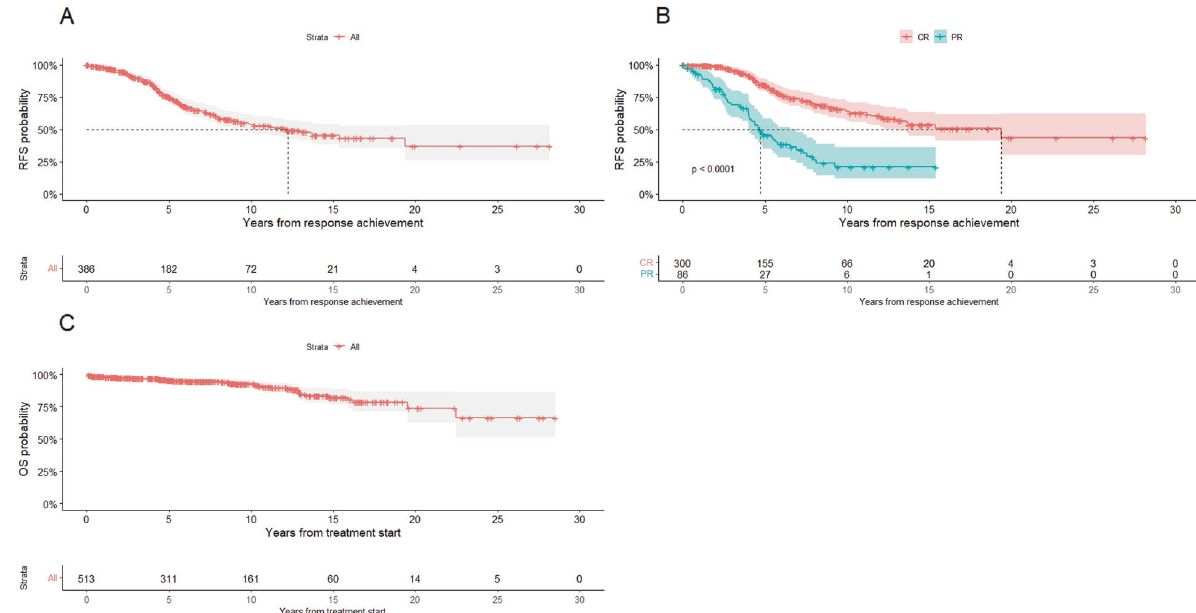
Fig. 2 Survival curves of the study population. A Global RFS of the study population. B RFS of the study population according to response. C OS of the study